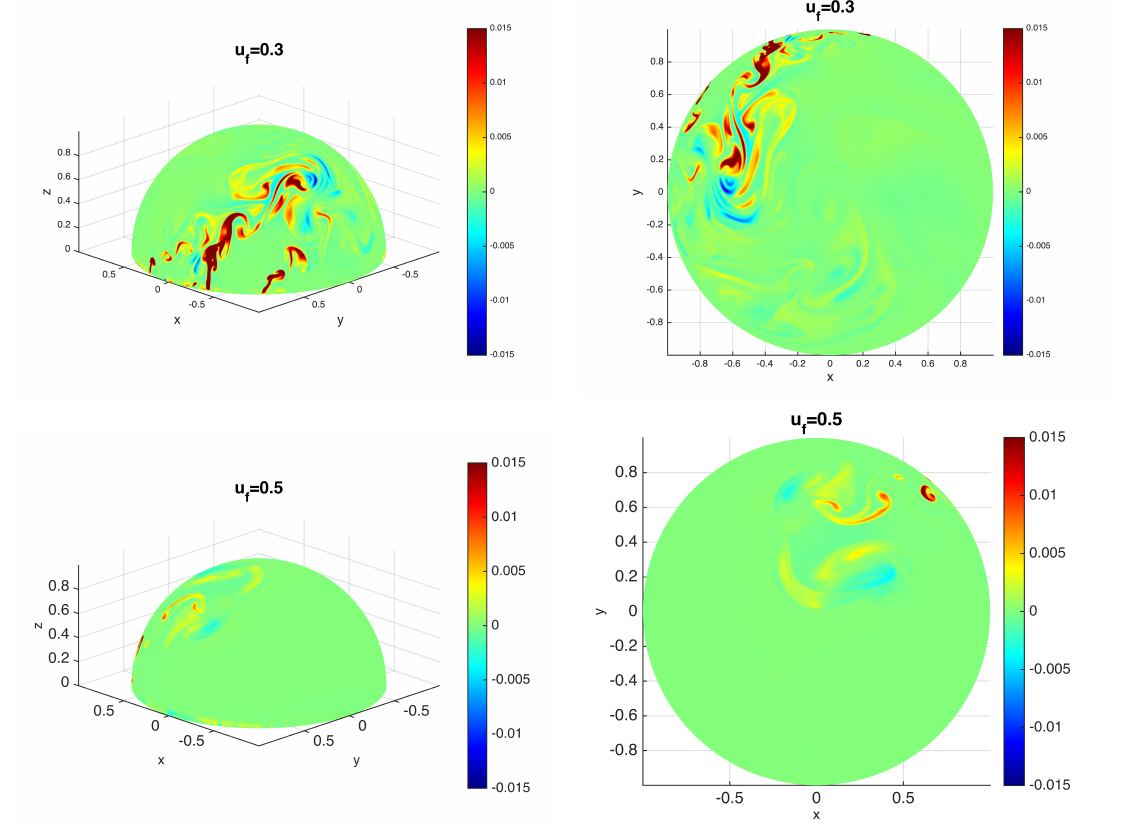
Figure 7. Convective heat flux fields with method 2. Top: U f = 0.3. Middle: U f = 0.5. Left: Side view. Right: North pole